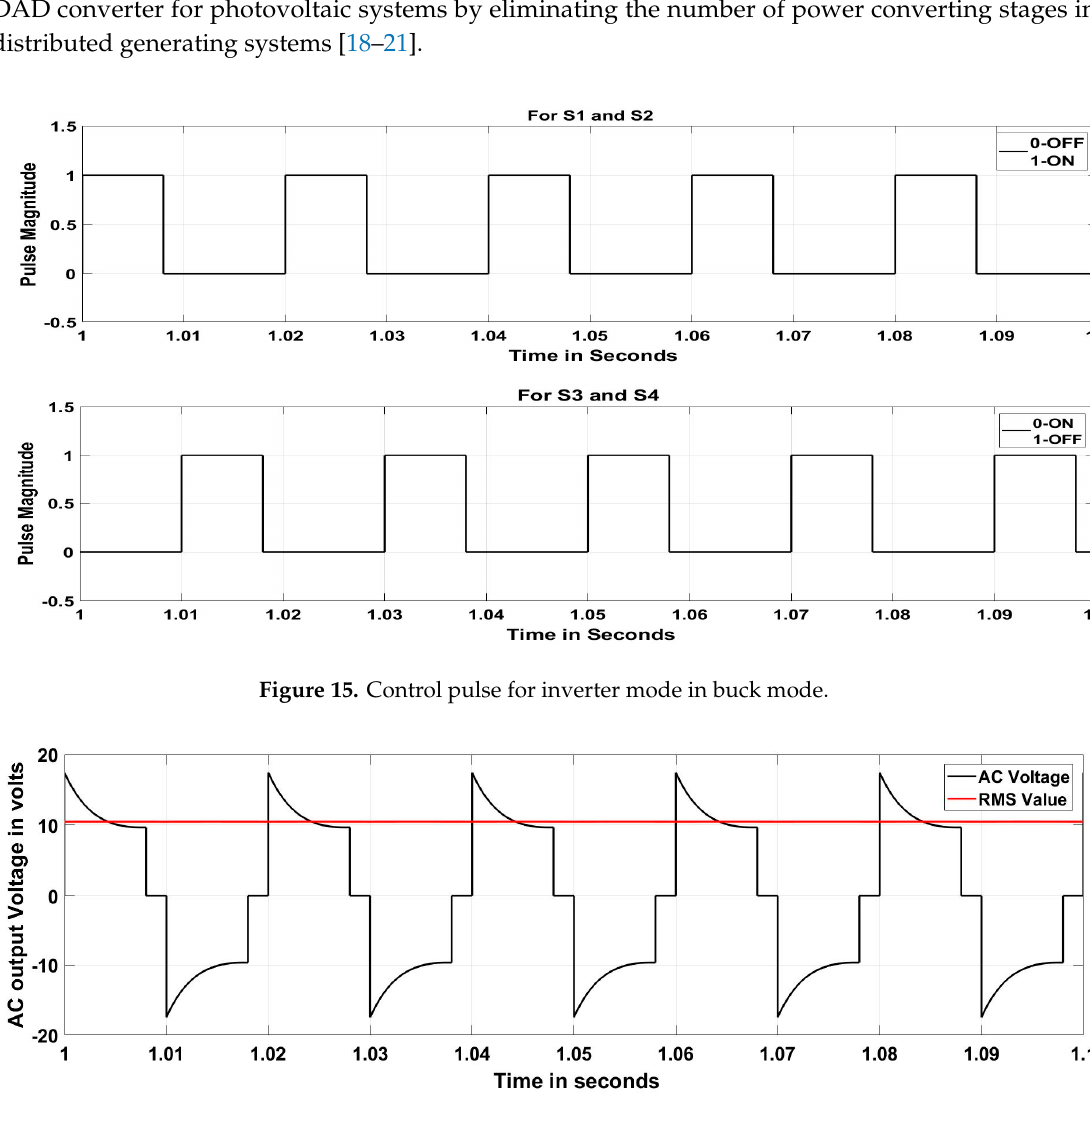
Figure 16. Simulated output of output voltage for inverter mode in buck mode.